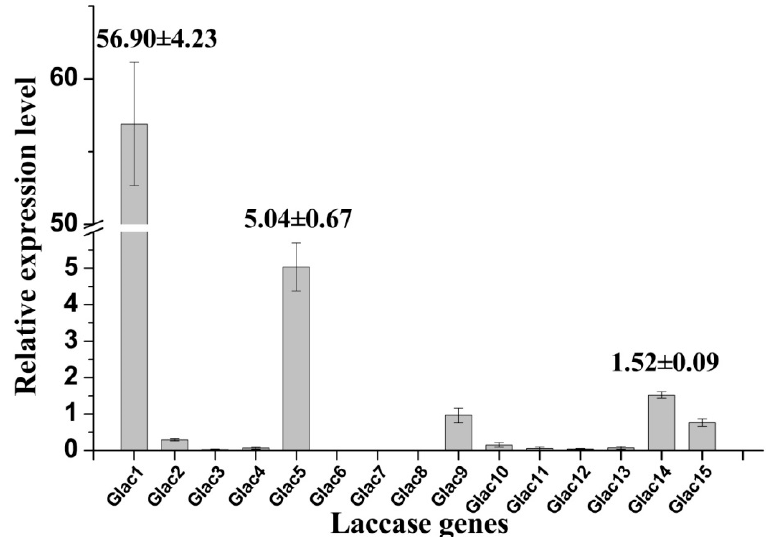
Figure 5. Relative expression levels of laccase gene of G. lucidum grown in EPM medium. The value represents the expression percentage of laccase gene accounts for the expression of RPL4 . The error bars represent the standard deviation of triplicate samples.